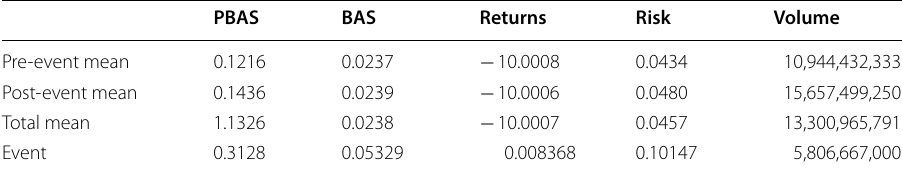
Table 3 Statistical mean for a 300-day event